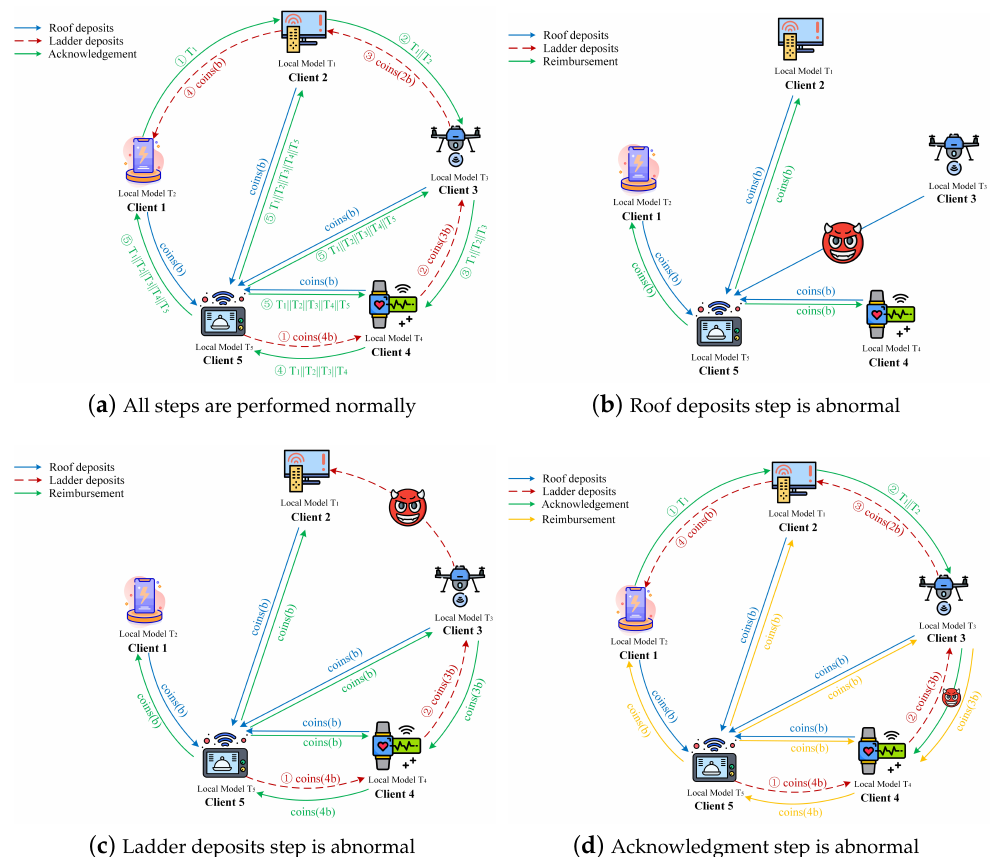
Figure 3. An example of the penalty mechanism in